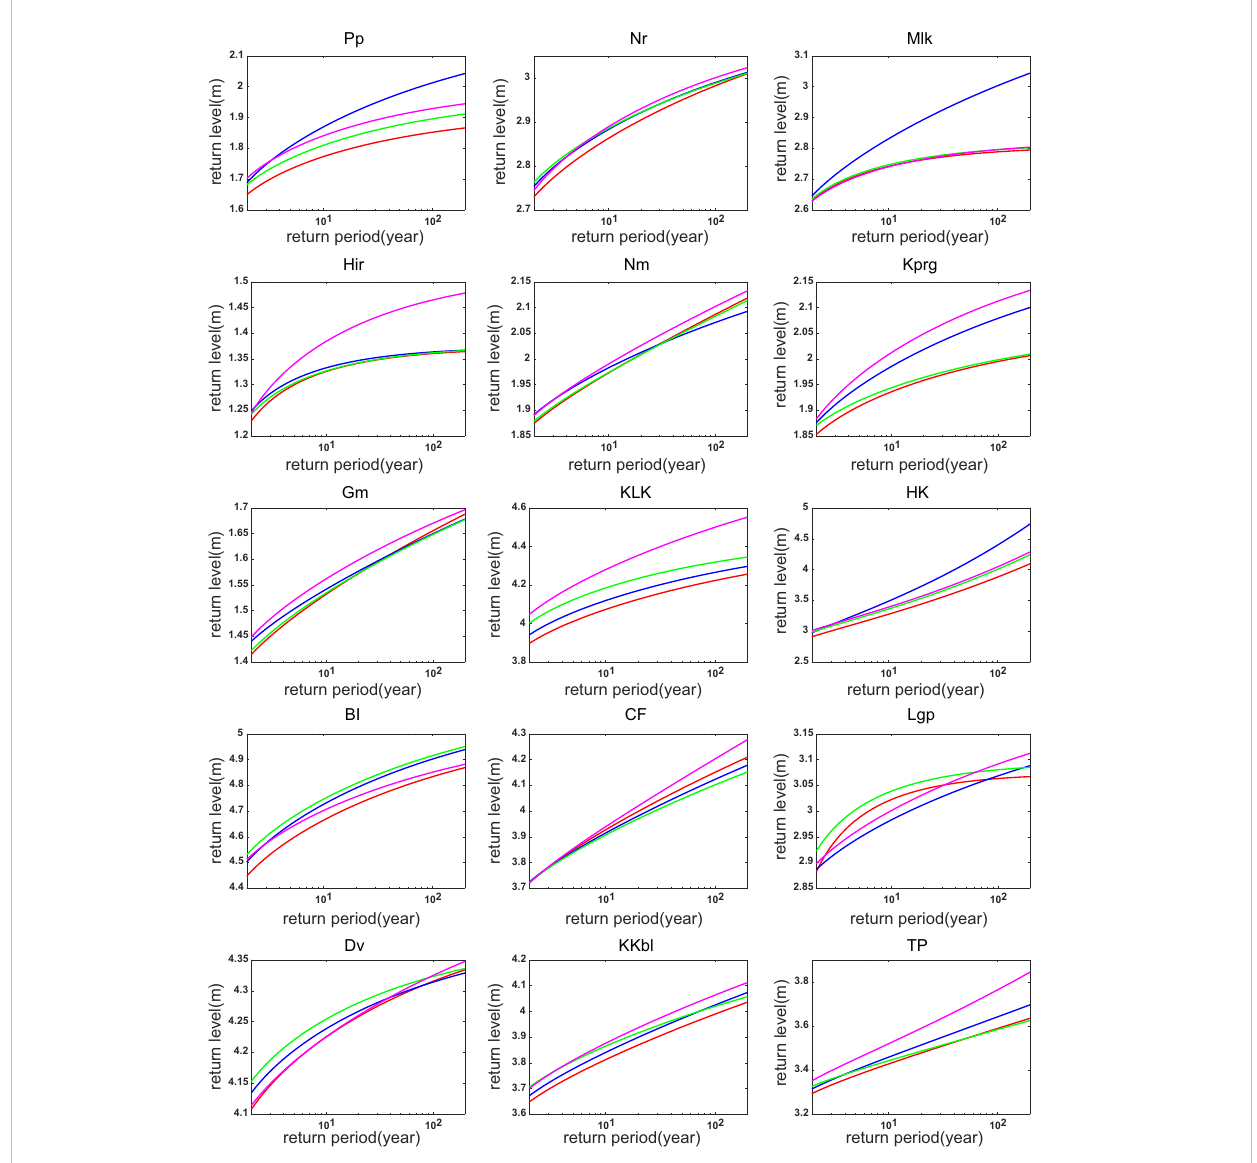
FIGURE 4 Return levels of the ESL at present (red line) and under the 1.5°C warming scenario: MIROC6 (blue line), CMCC-ESM2 (green line), EC-Earth3 (pink